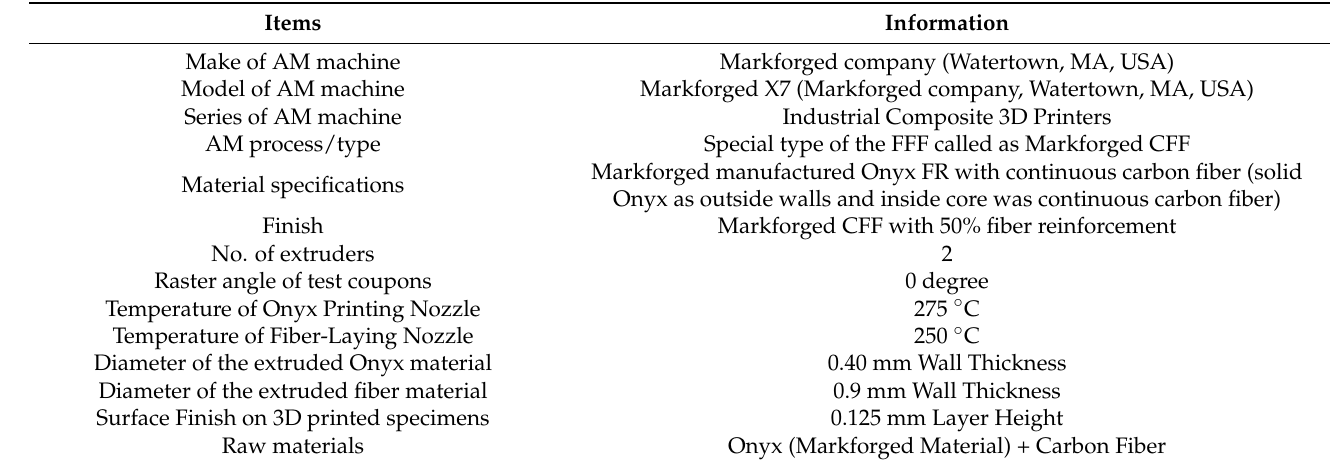
Table 1. AM, materials, and